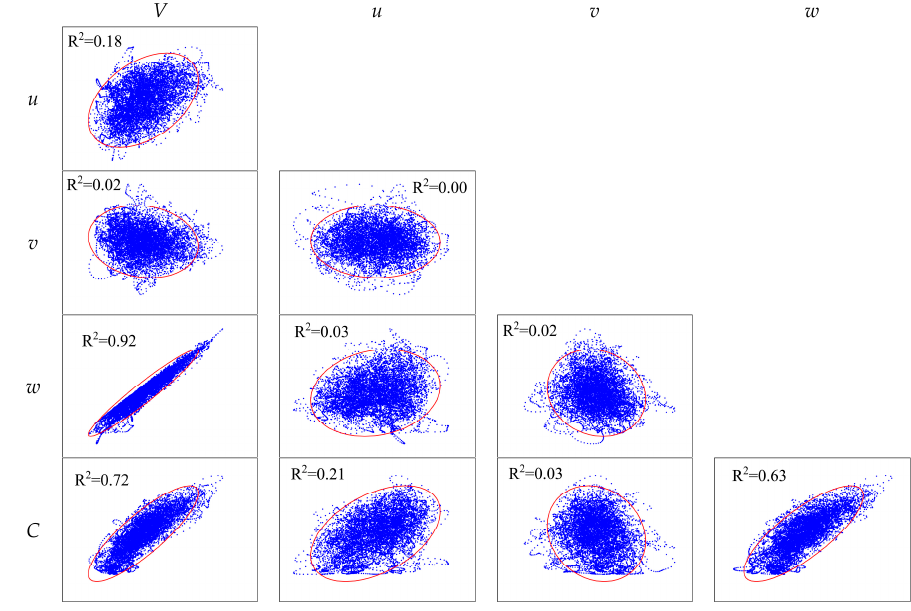
Figure 21. The correlations between velocity and concentration at Point